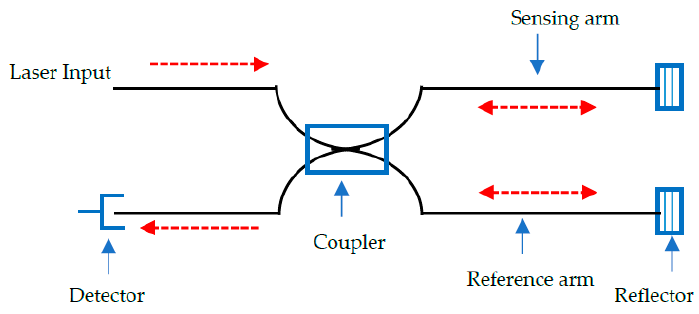
Figure 5. A fibre optic Michelson interferometer (after [93]).